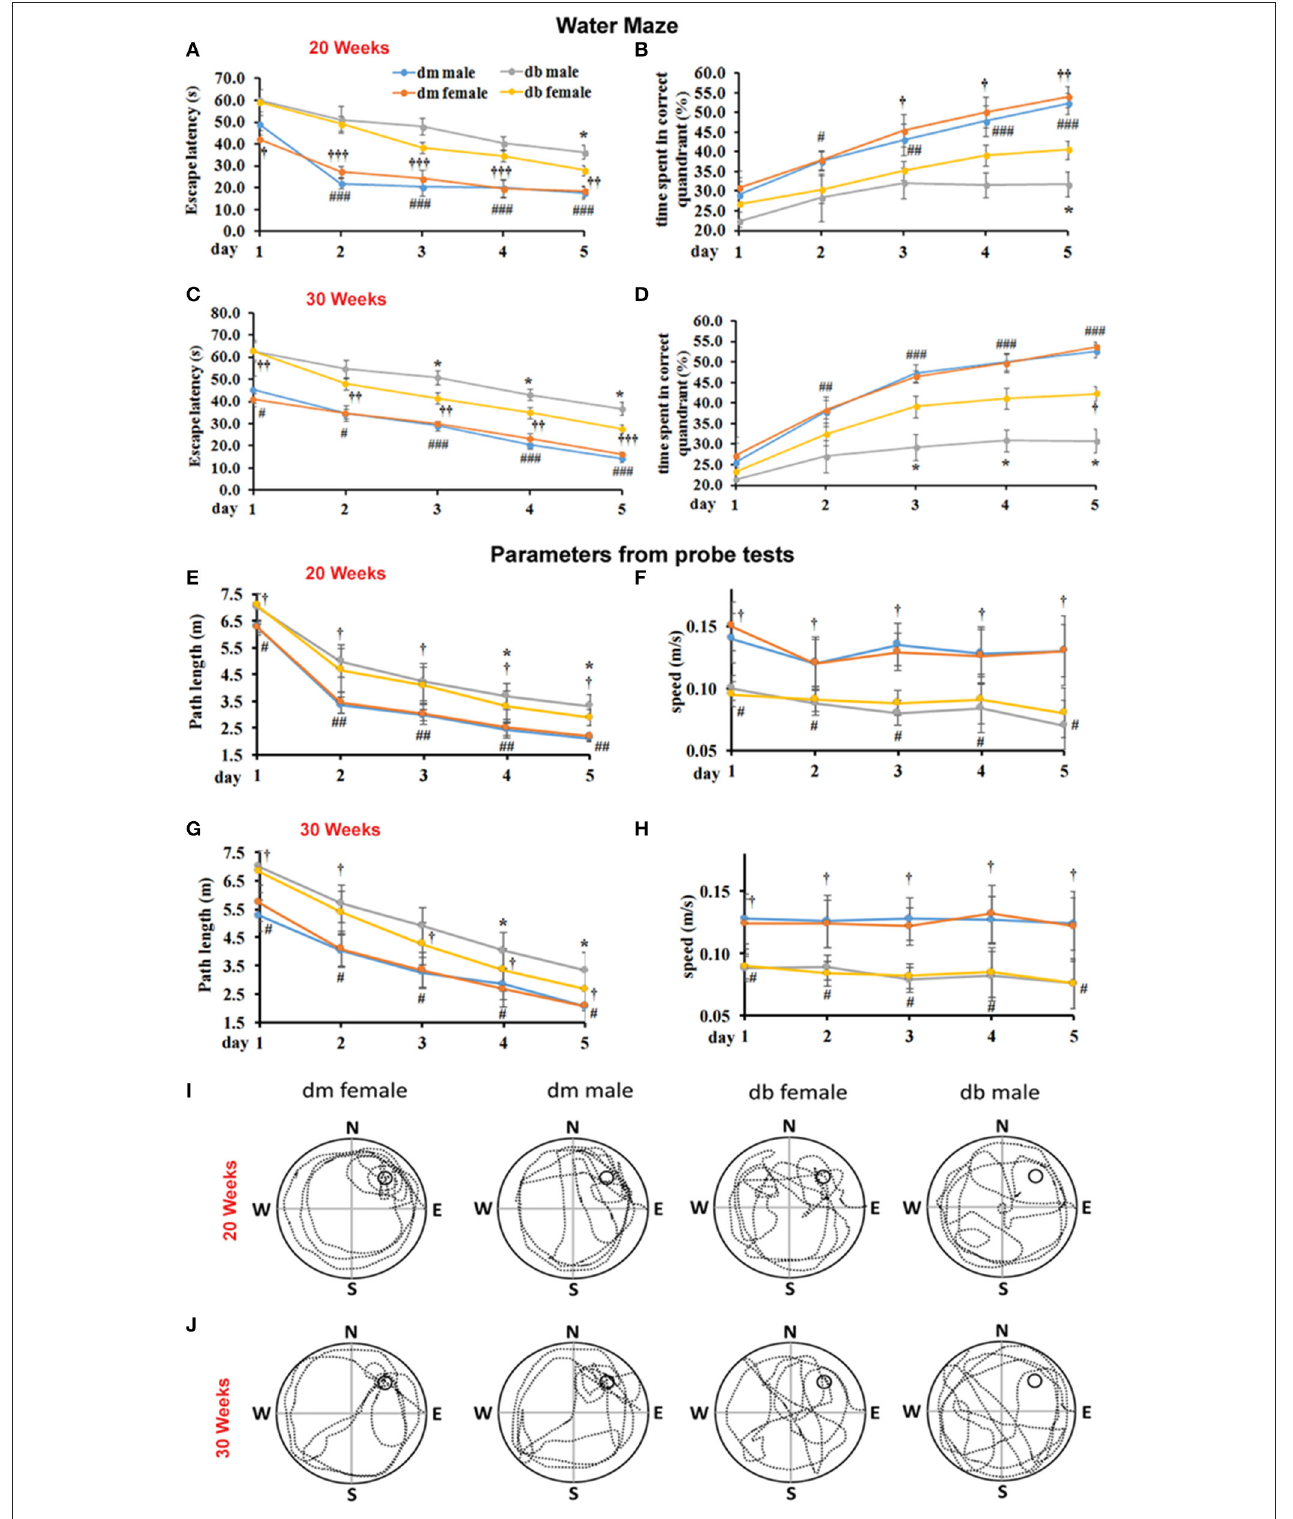
FIGURE 1 | The effect of sex difference on spatial memory performance. Morris water maze was used to test the spatial learning and memory. Male db/db mice aged 20 (A,B) and 30 weeks (C,D) spent significant time to locate the hidden platform in the correct quadrant as indicated by quantitative latency compared to female diabetic mice (A,C) . Male db/db mice also spent much less time in the correct quadrant (B,D) . Also, db/db mice aged 20 (A,B) and 30 weeks (C,D) spent significant